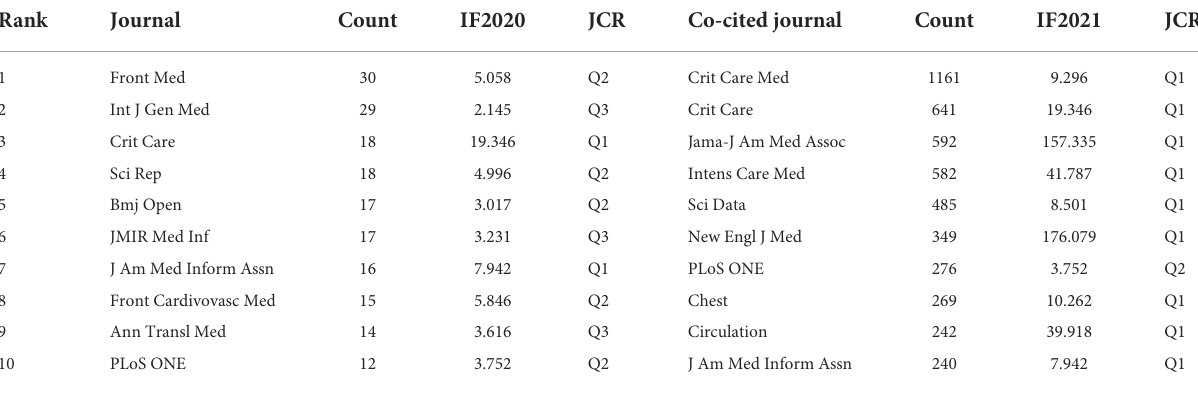
TABLE 1 Top 10 journals in terms of publications and top 10 journals in terms of co-citations.